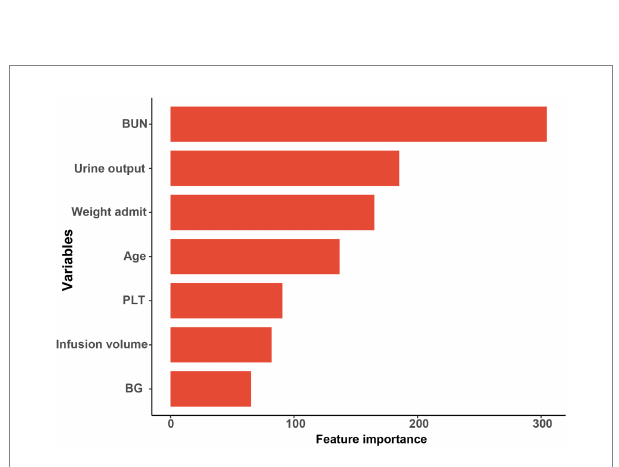
FIGURE 5 BUN, blood urea nitrogen; PLT, platelet count, BG, blood